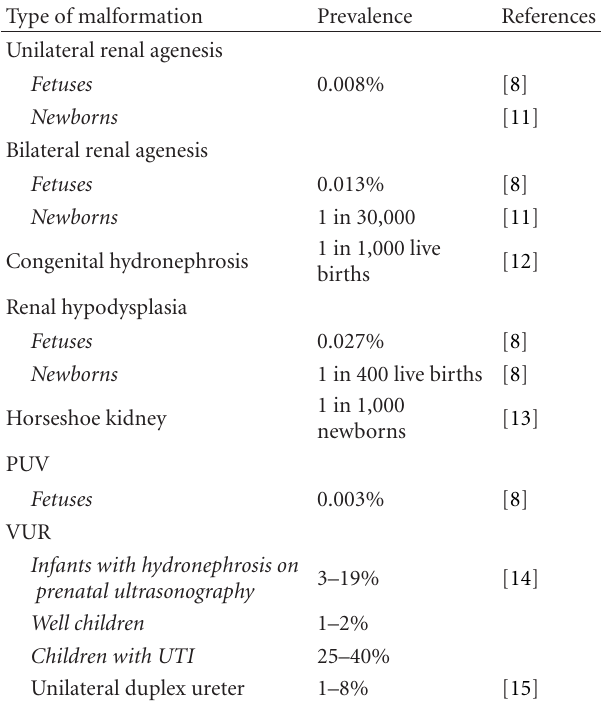
Table 1: Prevalence of